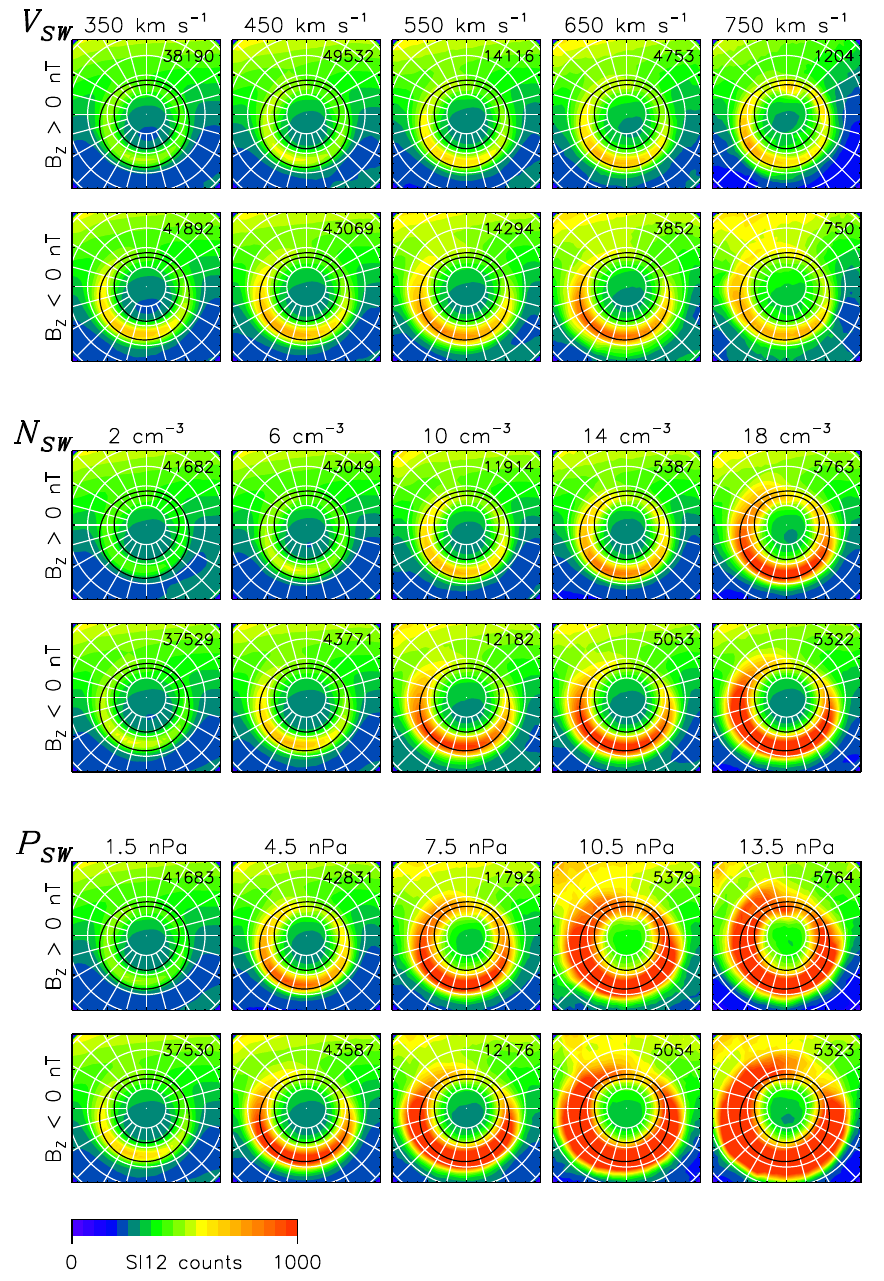
Fig. 3. Upper panels: Averaged SI12 observations parameterized by solar wind velocity. (Middle panels) Averaged SI12 observations parameterized by solar wind density. Bottom panels: Averaged SI12 observations parameterized by solar wind pressure. In each case the results are sub-divided for northward and southward